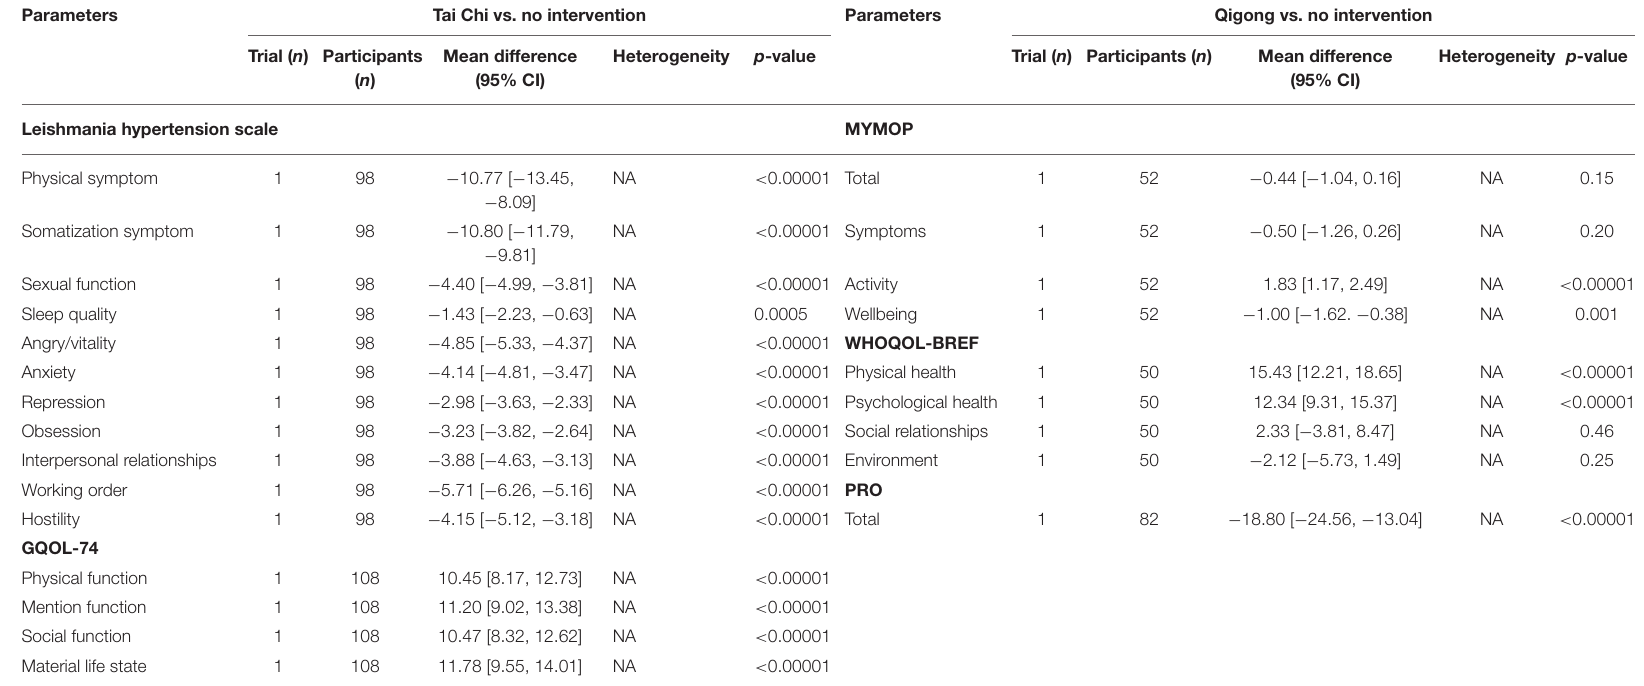
TABLE 3 | Summary of meta-analysis based on other QOL scales.